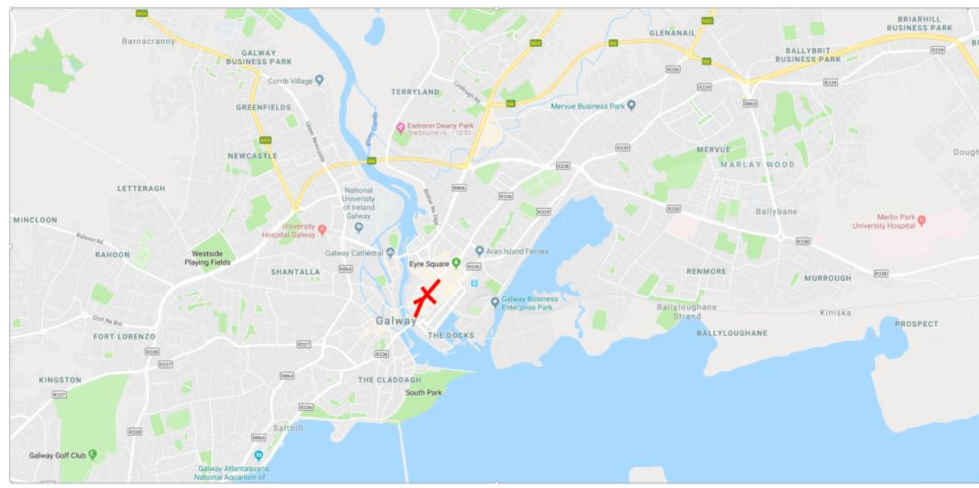
Figure 17. Map of Galway (pedestrianised streets in